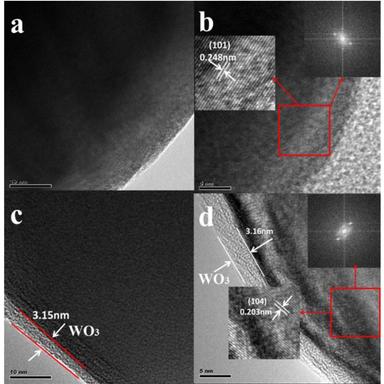
TEM images of (a, b) pristine LiNi0.6Co0.2Mn0.2O2 and (c, d) 1.0 wt%WO3 coated LiNi0.6Co0.2Mn0.2O2 and the insets in (b) and (d) show the corresponding FFT and IFFT.